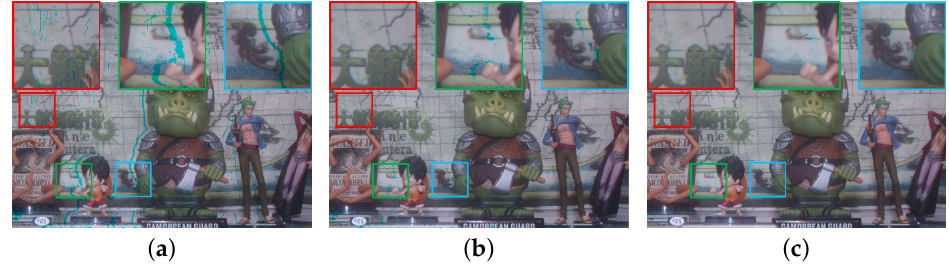
Figure 11. Comparison of color registration results: ( a – c ) registration using the initially aligned reference image, refinement with CMM, and refinement with enhanced